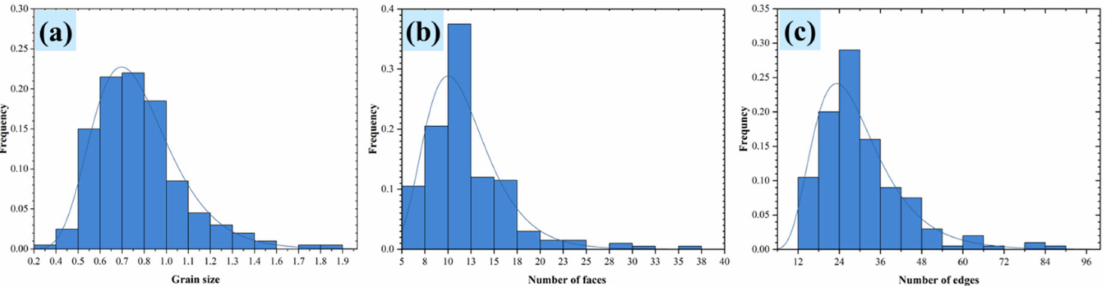
Figure 11. ( a ) The distribution of grain sizes, ( b ) the distribution of the face number, and ( c ) the distribution of the edge number of the 200-grain polycrystal